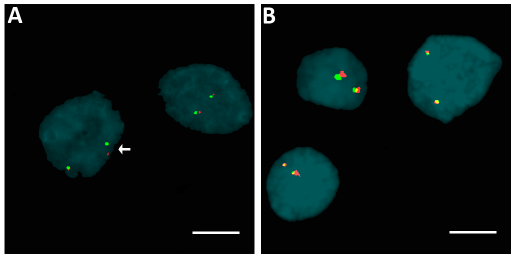
Figure 2. Examples of fluorescence in situ hybridization (FISH) in isolated nuclei for the identification of genes specifically rearranged in papillary thyroid carcinoma (PTC). Arrows point to the split of the red/green signal of a RET break-apart [19] probe in the case of sPTC, indicating broken RET ( A ); and to un-split red/green signals of an ALK break-apart probe in the case of fPTC, indicating unbroken ALK ( B ). Red spot : 300 kb probe DNA fragment; Green spot : 442 kb probe DNA fragment; Scare bar = 10 µm.